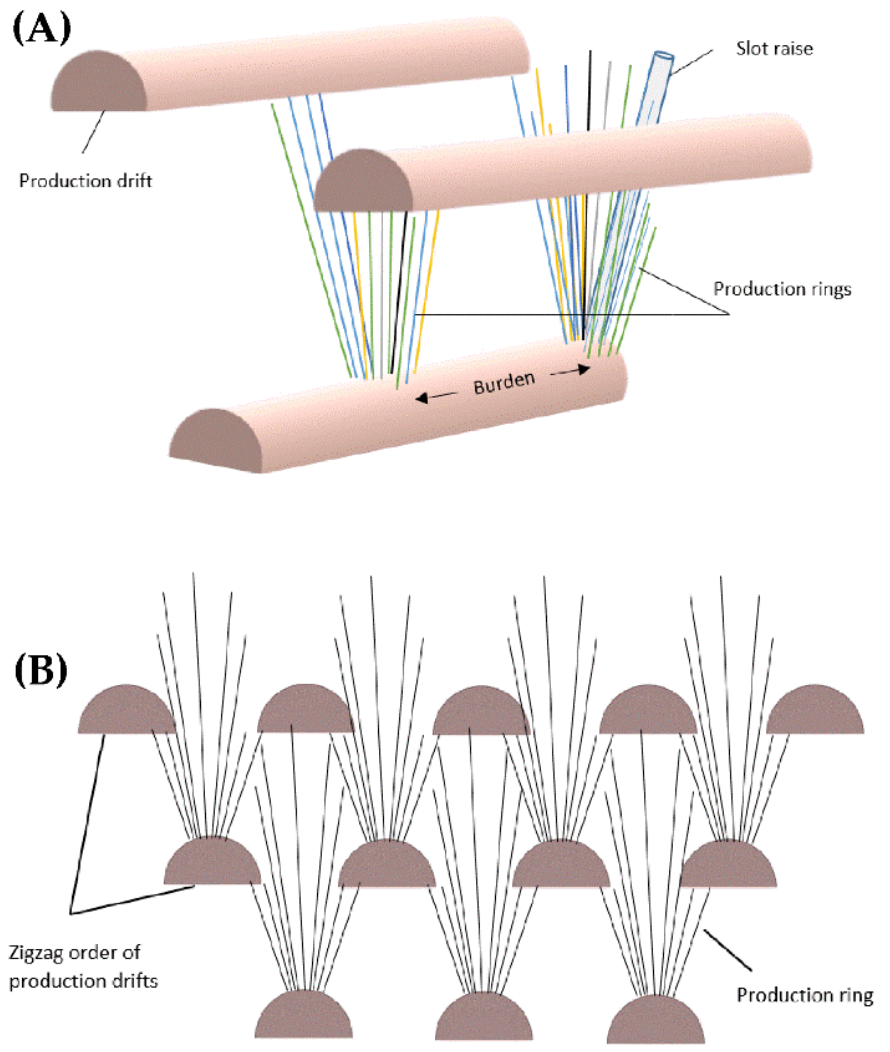
Figure 2. Schematic representation of drilling and blasting operation in an SLC mine. ( A ) Fan-shaped design of production rings. ( B ) Production drift pattern [2] .